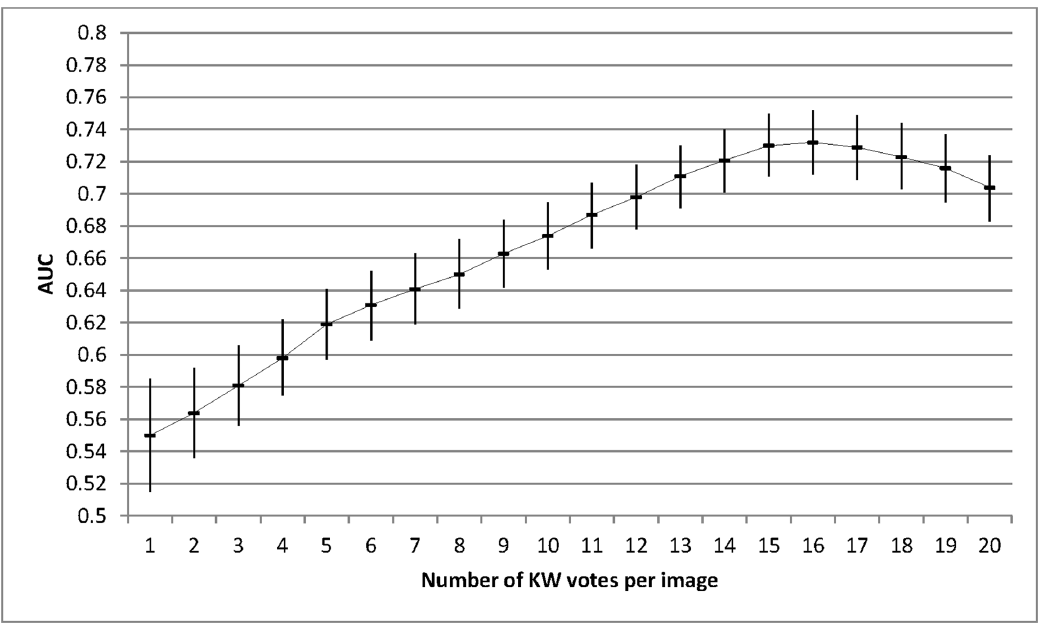
Figure 2. The AUC and associated 95%CI for trial 1 (0.03c) as a function of the number of KW gradings per image. The AUC increases as the number of KW gradings increases with a peak at 16 individual gradings per image. A similar curve was obtained for all study designs in both trials, although a variation was seen in the optimal number of KWs needed to achieve a peak ROC. doi:10.1371/journal.pone.0071154.g002 PLOS ONE |